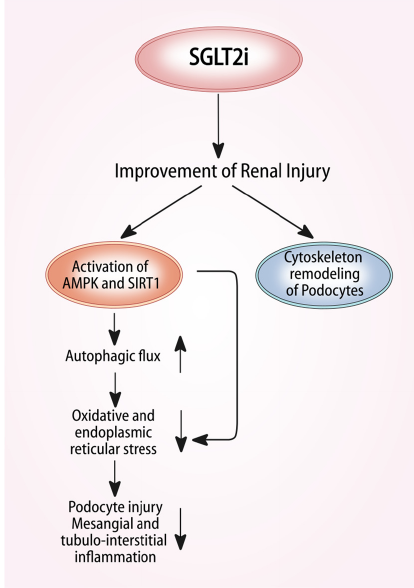
Figure 2. Pleiotropic e ff ects of sodium-glucose cotransporter 2 inhibitors (SGLT2i) and nephroprotection: SGLT2i induce both AMPK and SIRT1, both stimulate authophagy, thus reducing cellular stress, glomerular and tubular injury [25,26]. Abbreviations : AMPK, adenosine monophosphate-activated protein kinase; SIRT1,